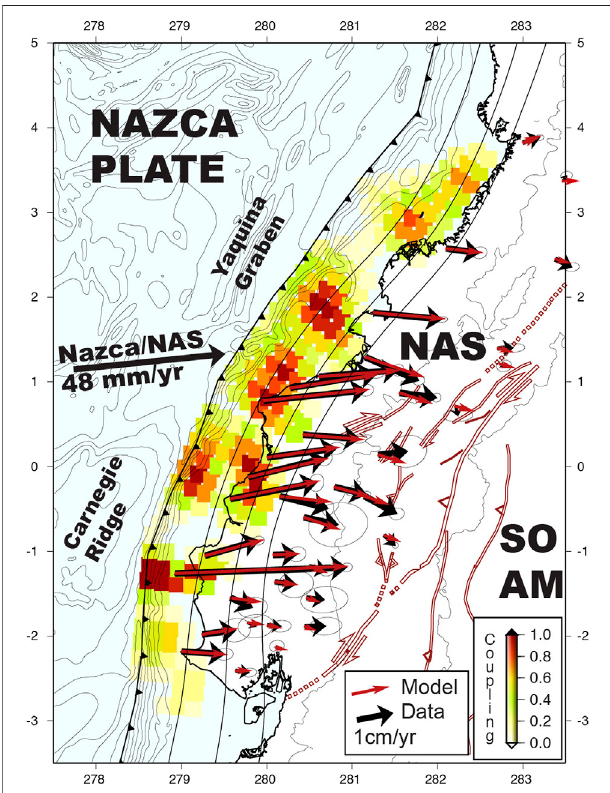
FIGURE 3 | Average interseismic coupling model derived from the inversion of interseismic GPS velocities along the Ecuador – Colombia subduction zone. The global moment de fi cit rate (in Newton. meter per year, Nm/yr) is 0.85 × 10 20 N-m/yr. Black and red arrows represent the observed and predicted GPS velocities, respectively. Hot colors patches indicate highly locked areas of the megathrust